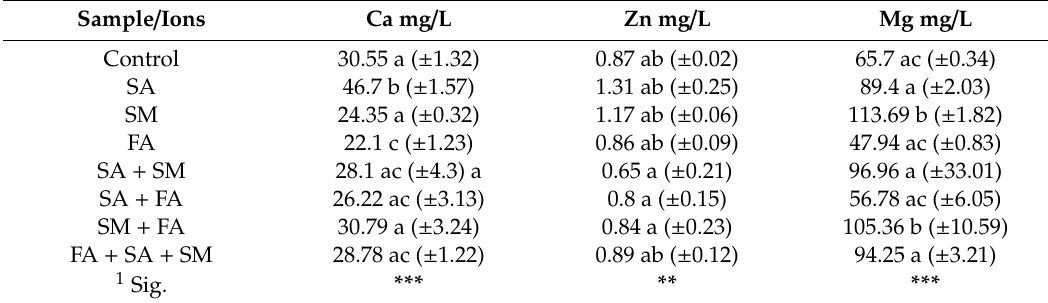
Table 4. The content of selected ions in ciders fermented by wild yeast (D), with the following additions: SA—ammonium sulfate, SM—magnesium sulfate, FA—ammonium